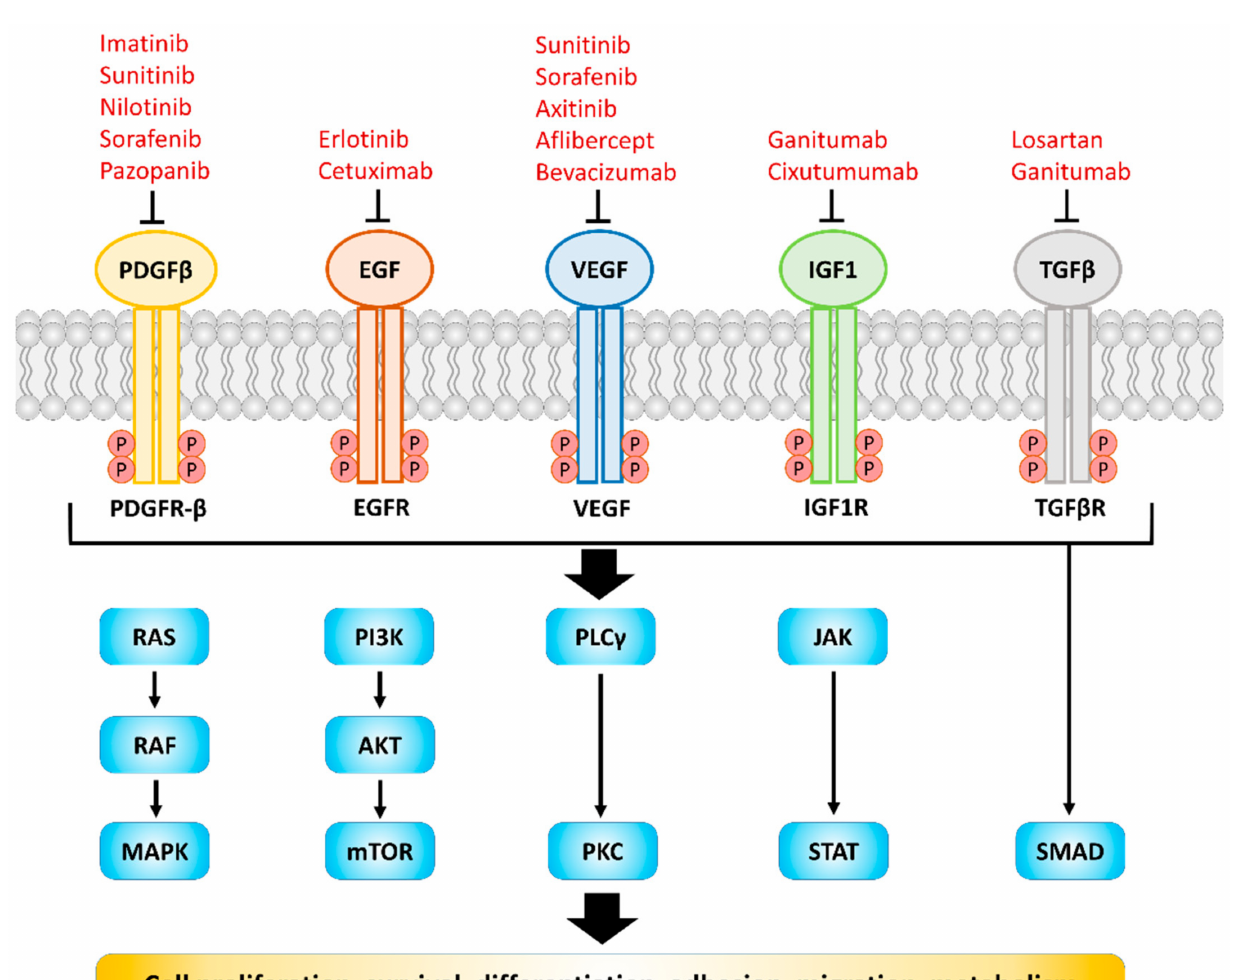
Figure 1. RTKs/TGF β R and their ligands which involved in regulating biochemical signal and cellular behaviors. Dys- regulation of these receptors and ligands is found in most human cancers. Representative drugs targeting corresponding RTKs/TGF β R are shown. RAS, rat sarcoma; RAF, rapidly accelerated fibrosarcoma; MAPK, mitogen-activated protein kinase; PI3K, phosphatidylinositol-3-kinase; AKT, protein kinase B; mTOR, mechanistic target of rapamycin; PLC γ , phos- pholipase C- γ ; PKC, protein kinase C; JAK, Janus kinase; STAT, signal transducer and activator of